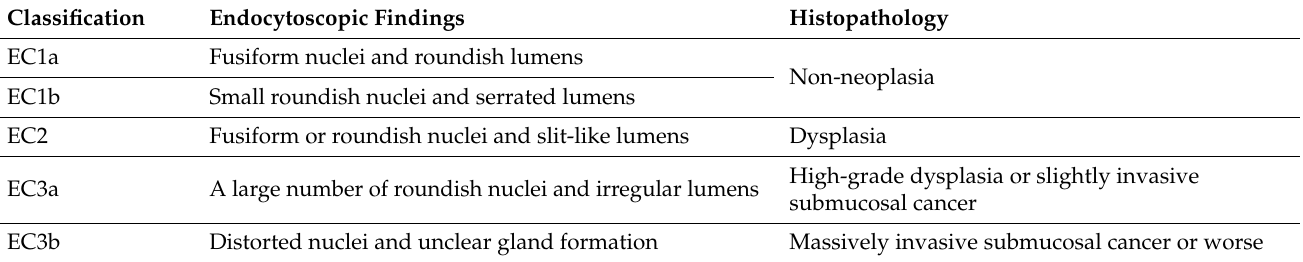
Table 6. Endocytoscopic